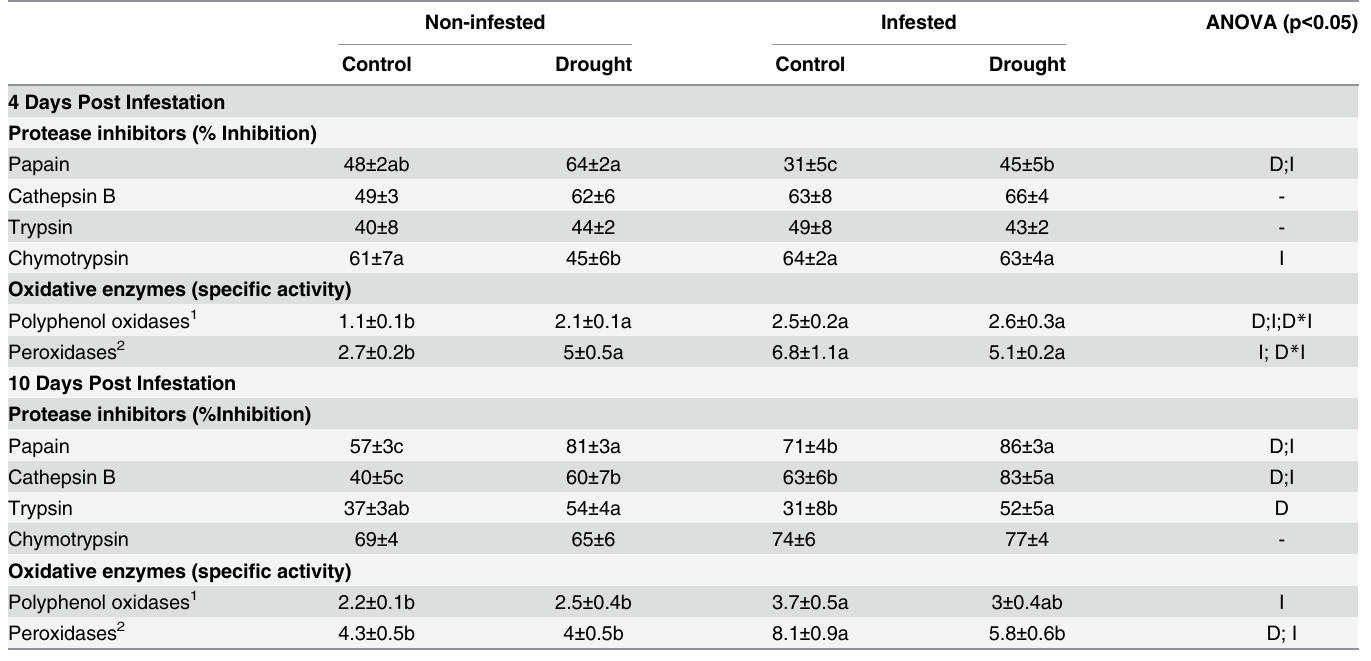
Table 2. Effect of moderate drought and T . evansi infestation on plant defense proteins in tomato leaves at 4 and 10 days post infestation.